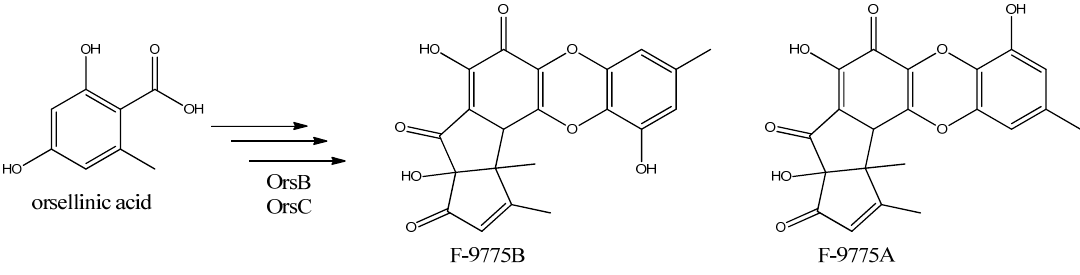
Figure 12. The proposed enzymes involved in the biosynthesis of F-9775A and F-9775B of the figure